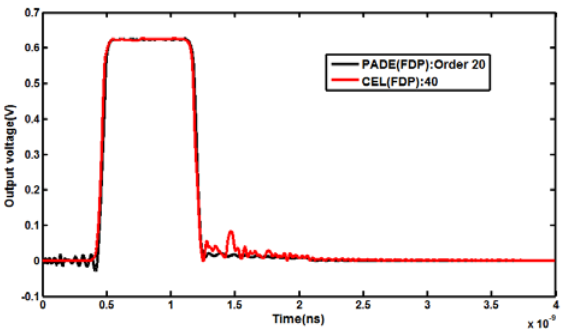
Fig. 10. Transient response of the circuit shown in Fig. 2 from [17]